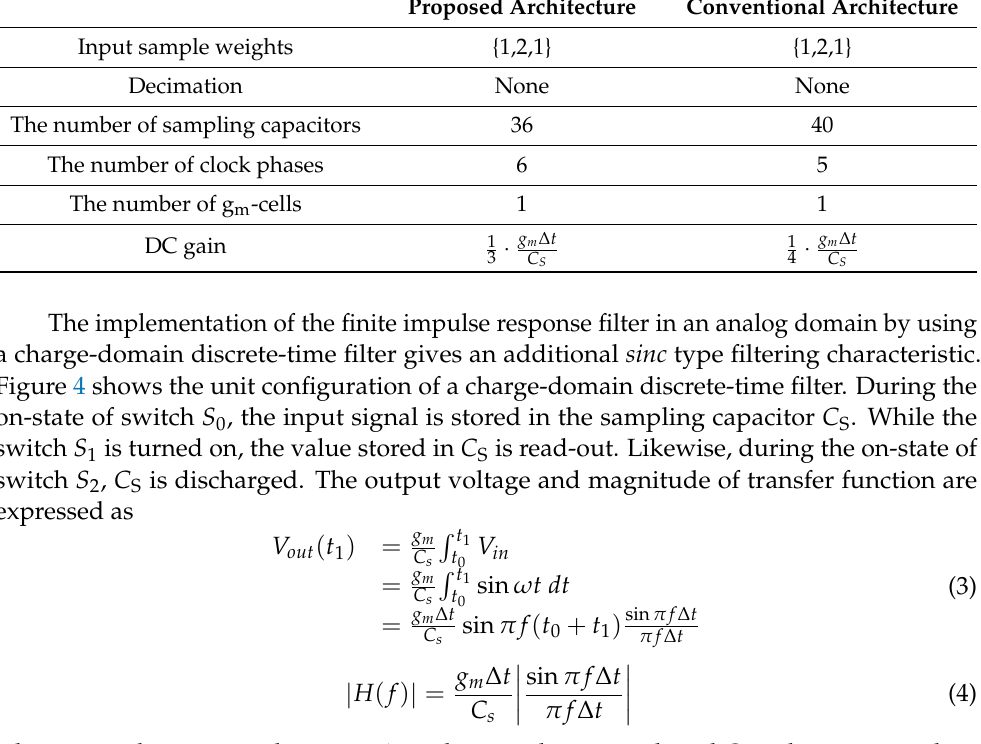
Table 3. Performance comparison between the proposed and conventional architectures.